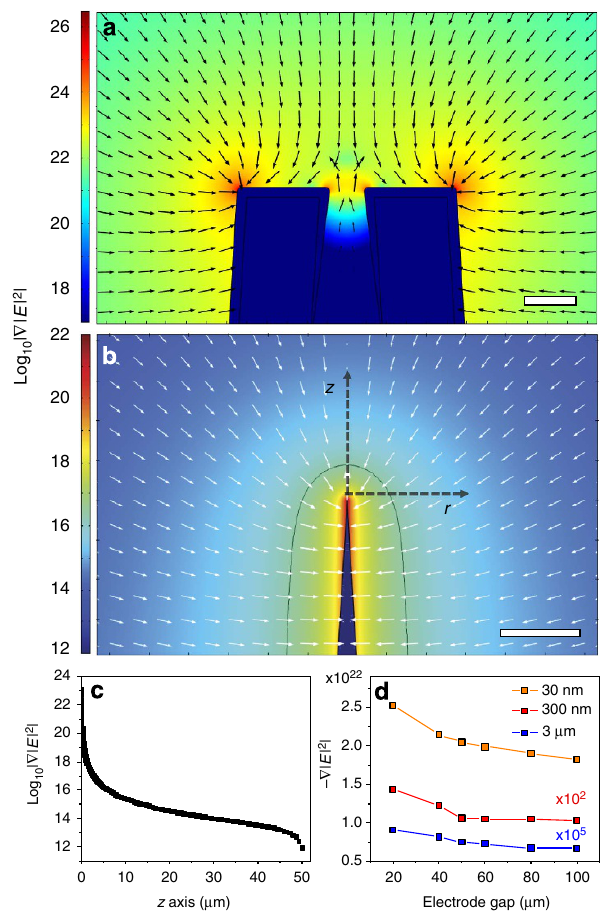
Figure 2 | Finite-element method modelling of DEP with the nanopipette. Two-dimensional-axisymmetric electrostatic modelling of a 50 m m electrode gap between the nanopipette tip and a conductive flat electrode was simulated with a 10V DC signal applied. Plots of the magnitude of the field intensity gradient, which is proportional to the force on a particle, are shown for regions ( a ) near the end of the pipette (scale bar, 25nm) and ( b ) the DEP trapping volume and surrounding area (scale bar, 10 m m). The logarithmically scaled arrows show the direction of the force. The black contour line in b is along | r | E | 2 | ¼ 10 16.4 V 2 m (cid:2) 3 , which corresponds approximately to the threshold field intensity gradient for trapping 10kbp DNA against Brownian motion. ( c ) The magnitude of the field intensity gradient along the z axis (black dashed arrow) in b . ( d ) The strength of | r | E | 2 | was also tracked at different distances from the tip of the nanopipette along the z axis for electrode gaps ranging from 20 to 100 m m with a 10V DC applied signal. The field intensity gradient strength decreases logarithmically with increasing gap